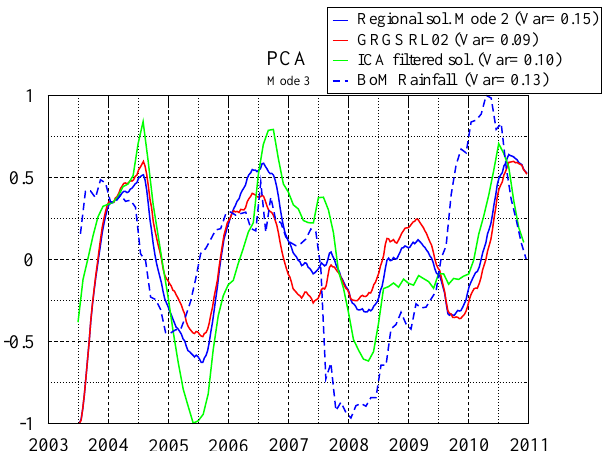
Fig. 11. Temporal components of PCA 2nd orthogonal mode of regional solutions and 3rd mode of GRGS, ICA 400km-filtered solutions and Rainfall product).